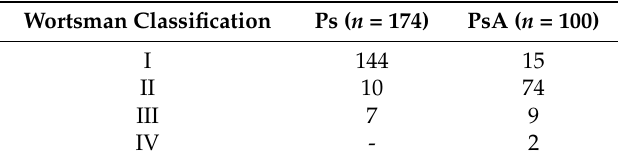
Table 2. Wortsman classification of the psoriatic nails studied.